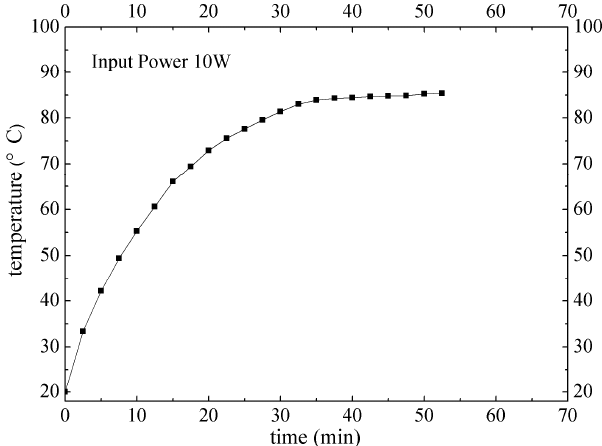
Figure 17. Heat transfer performance of phase change heat sink under the input power of 10 W.